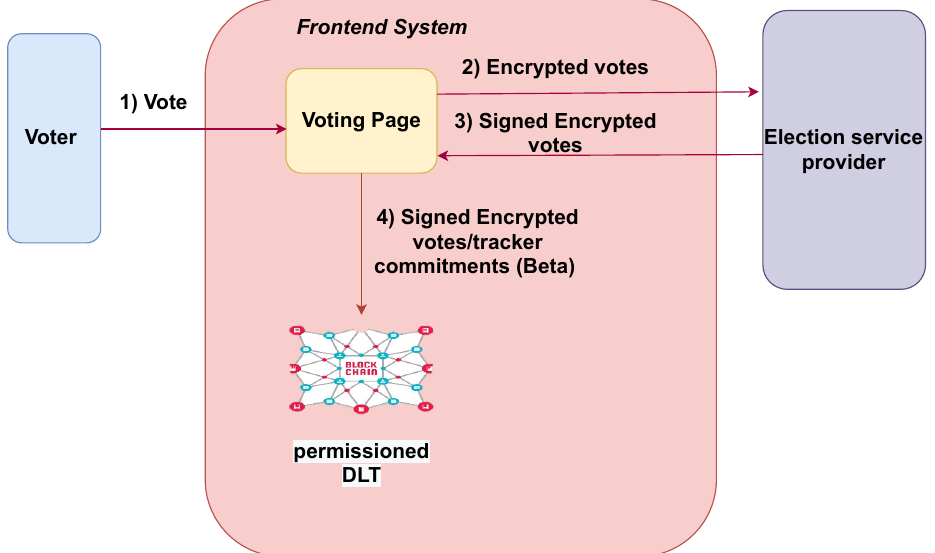
Figure 5. Voter experience during the voting phase: Once authentication is complete, the voter is forwarded to the voting webpage. The voter is shown the choices and is allowed to make their